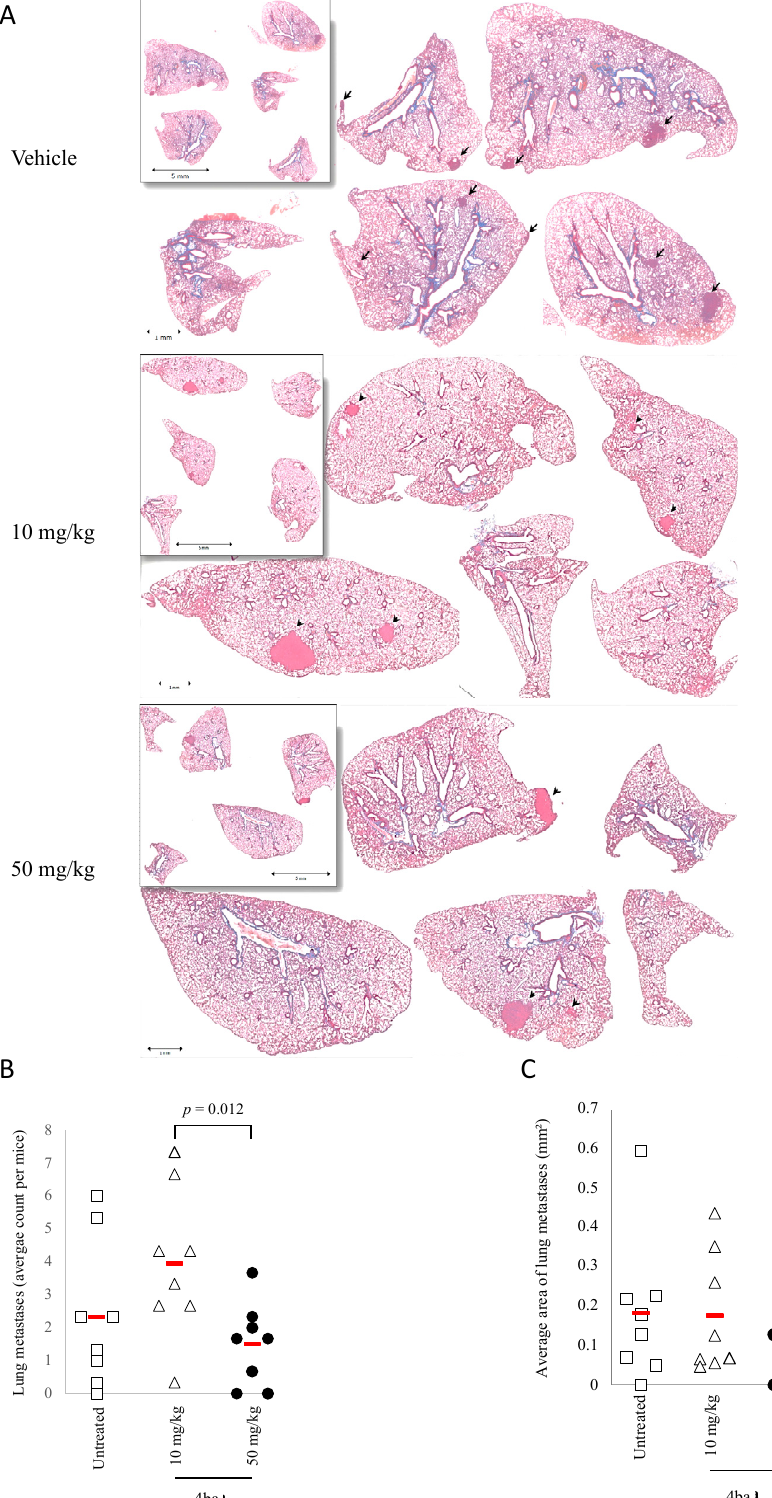
Figure 10. Pyridazinone scaffold-based molecule effect on lung metastases in an orthotopic osteosarcoma model. Representative field of lung metastases ( A ). Quantification of lung metastases number after treatment with vehicle (white square), compound 4ba at 10 mg/kg (white triangle) and at 50 mg/kg (black circle) ( B ) and metastases surface ( C ). n = 8. The brackets indicate the conditions compared.